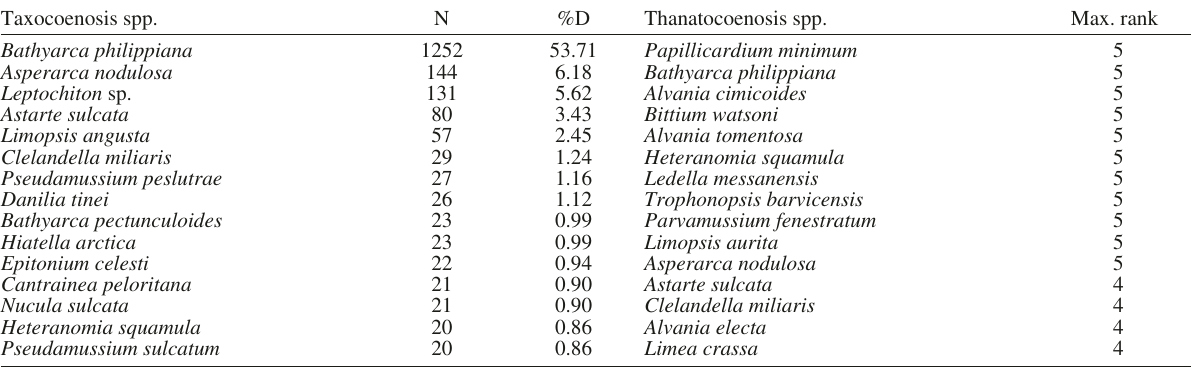
Table 3. – Number of individuals collected alive (N) of the top-dominant species found on the Gazul mud volcano (including the mud volcano edifice, erosive depression and adjacent bottoms), with their dominance index (%D) and the maximum observed rank (4, 31-100; 5, >100 shells) of the most representative species of the thanatocoenosis, all samples. Taxocoenosis spp.